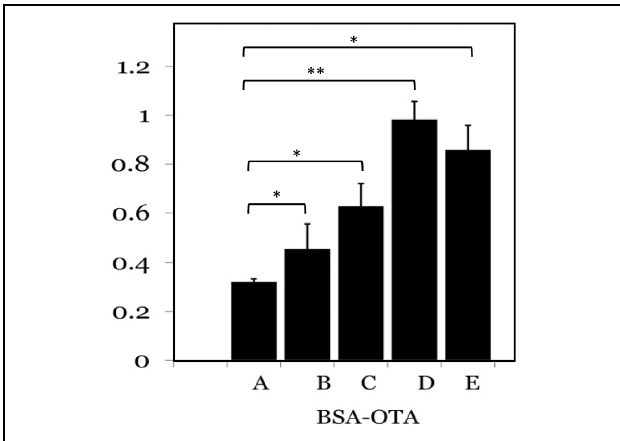
FIGURE 1 | Determination of antigenicity of protein: OTA conjugates. Different protein to OTA ratios were used as antigens and probed with specific sera from mice. A-1:5; B-1:10; C-1:25; D-1:50; E-1:100 protein to OTA ratio. ∗ P ≤ 0.05; ∗∗ P ≤ 0.01.